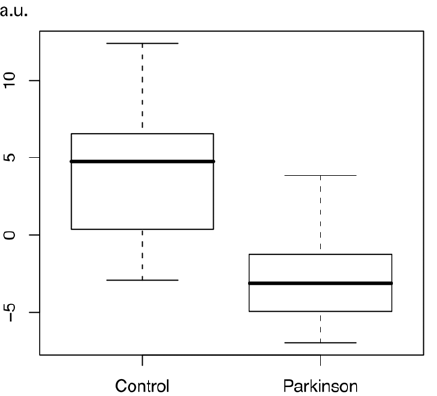
Figure 2. Effect size at the peak of significance. Boxplot of the peak of significance value (arbitrary unit) for each participant in both groups, as obtained by SPM5 ‘fitted response’ plot function. Peak value was adjusted, meaning that the effect of age, gender and global WM volume were factored out, and only the effect of condition (Parkinson or Control) and the residuals remained, as assessed by the SPM model. For each group, bold line shows the median, central box includes the middle 50% of the data, and tails of the boxplot show the minimum and maximum values.